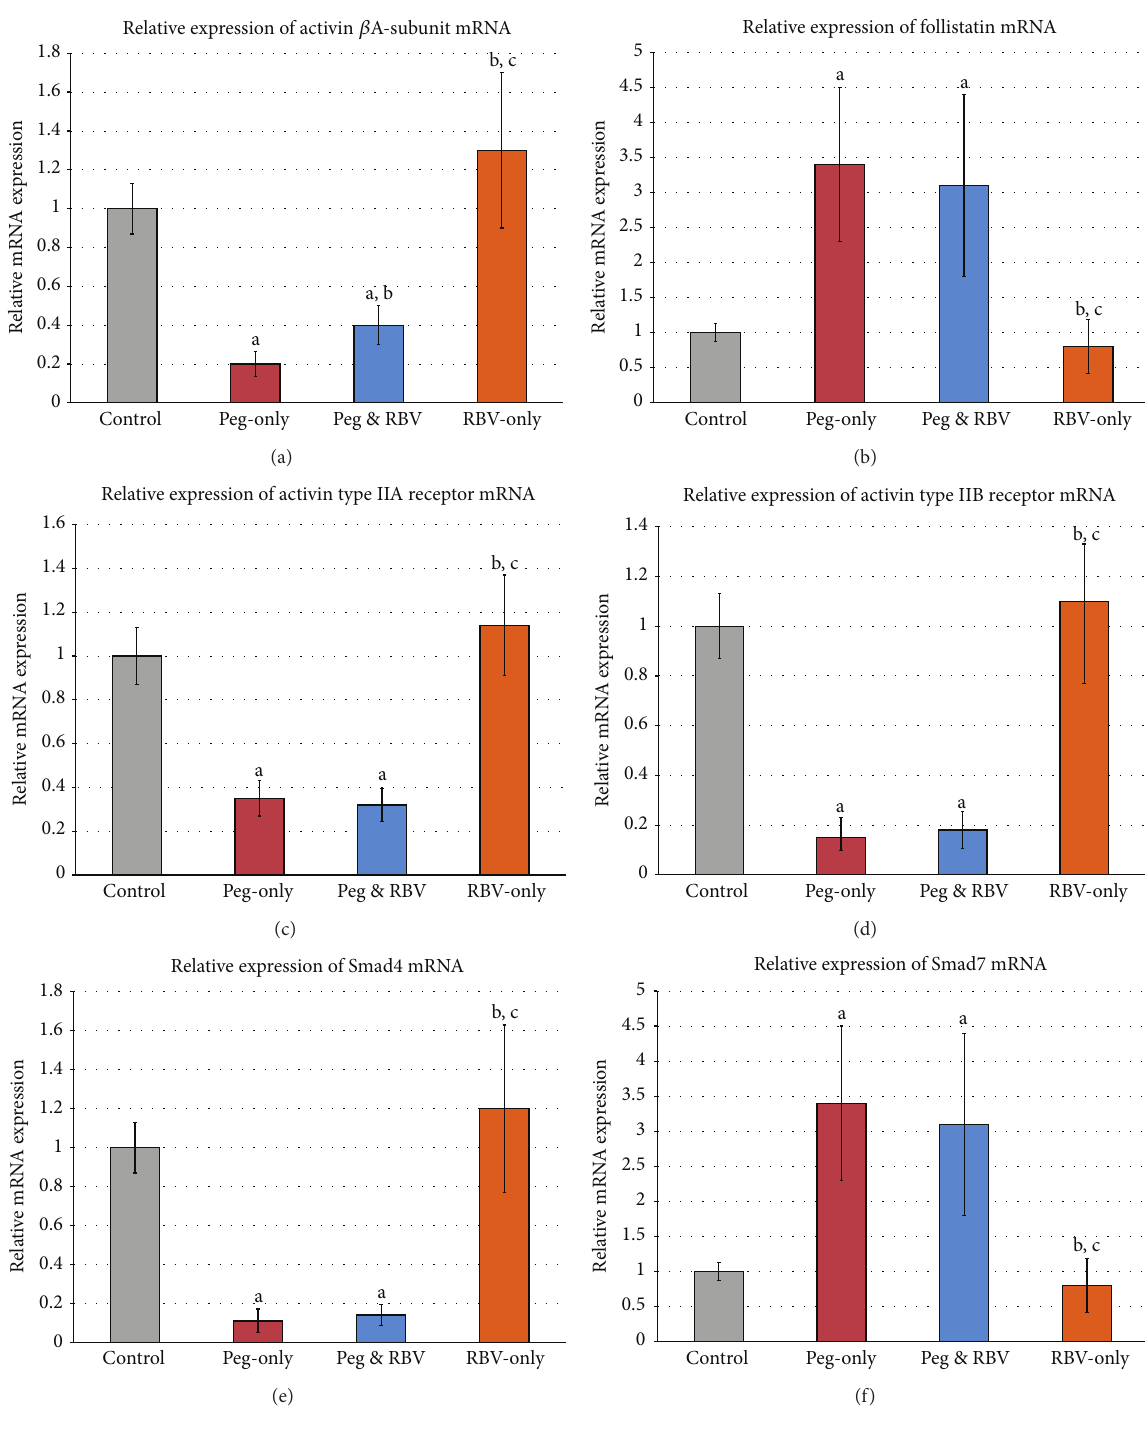
Figure 5: Relative concentration of messenger RNA expression of (a) activin 𝛽 A-subunit, (b) follistatin, (c) type IIA receptor, (d) type IIB receptor, (e) Smad4, and (f) Smad7 in the different study groups ( a 𝑃 < 0.05 compared to control, b 𝑃 < 0.05 compared to Peg-only, and c 𝑃 < 0.05 compared to Peg & RBV